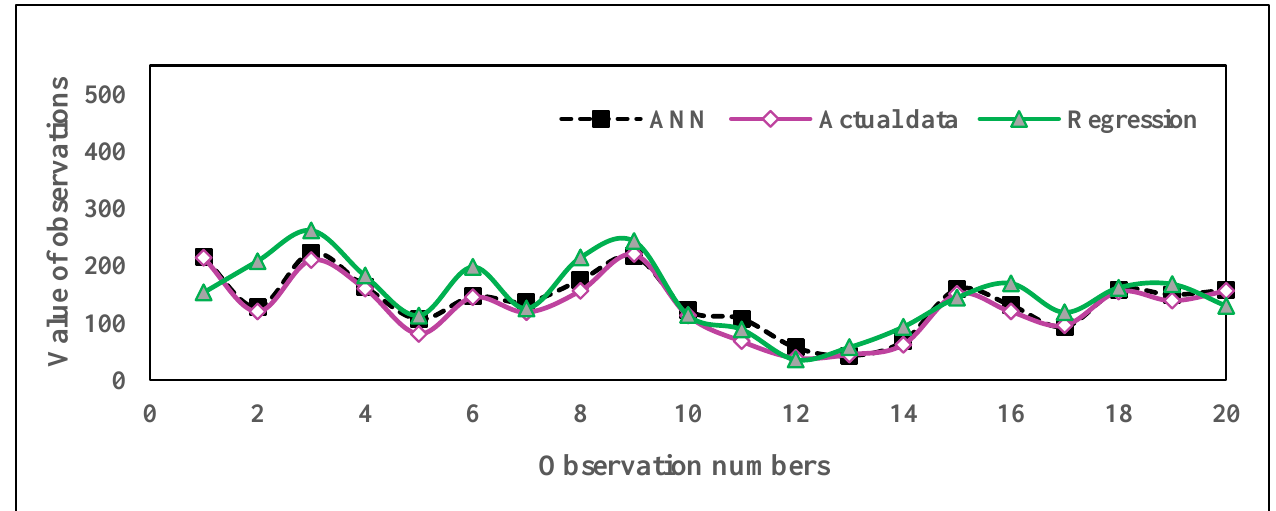
Table 4. Prediction performance of the fitted models in the testing stage.